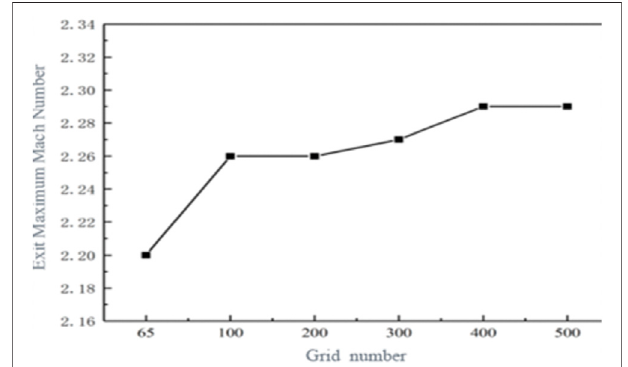
FIGURE 2 | Exit maximum Mach number of different gird numbers.